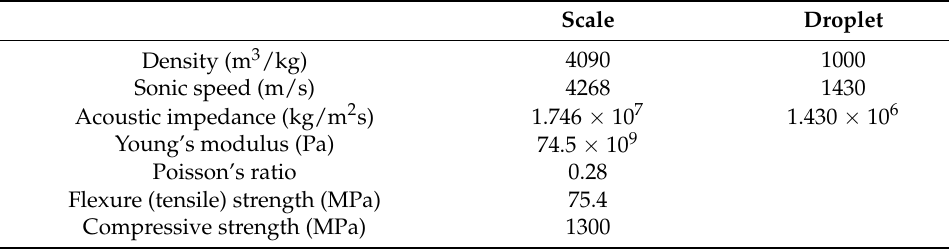
Table 1. The physical properties of scale and